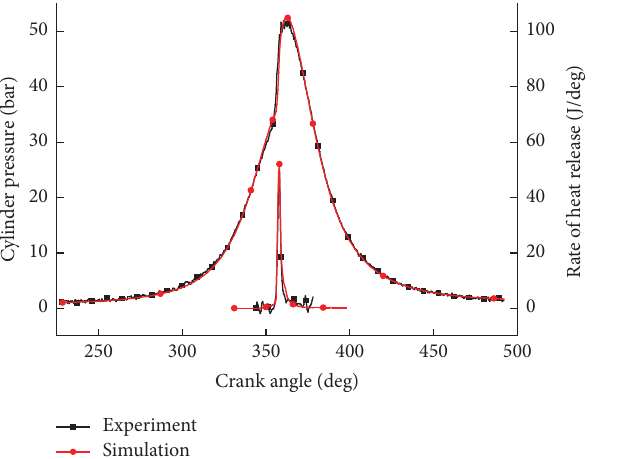
Figure 2: The adaptation verification for the 3D simulation models of the 4135ACa engine.